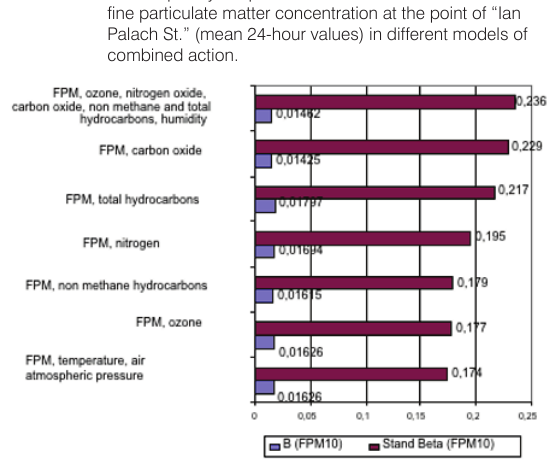
Figure 1. Regression coefficients of the linear correlation between AMI frequency hospitalizations in the citizens of Varna and fine particulate matter concentration at the point of “Ian Palach St.” (mean 24-hour values) in different models of combined